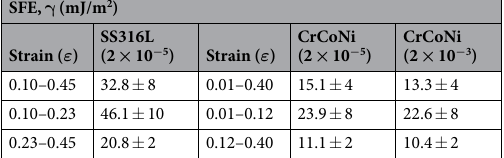
Table 2. Stacking fault energies (SFE, mJ/m 2 ) averaged at corresponding strain ranges in AM SS 316 L and AM CrCoNi alloys. The strain rates during tensile loading were marked in